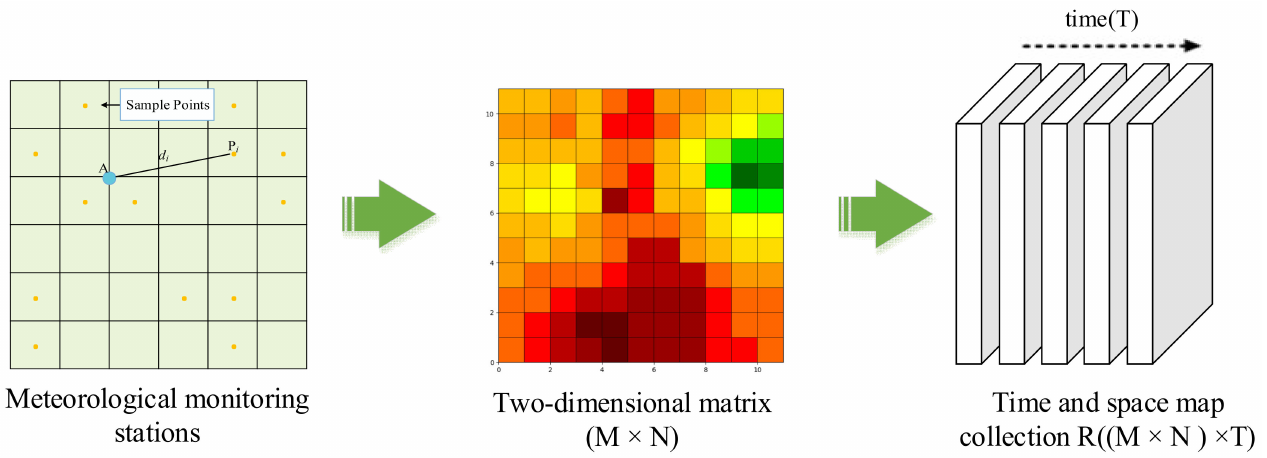
Figure 3. Spatiotemporal graph construction process.